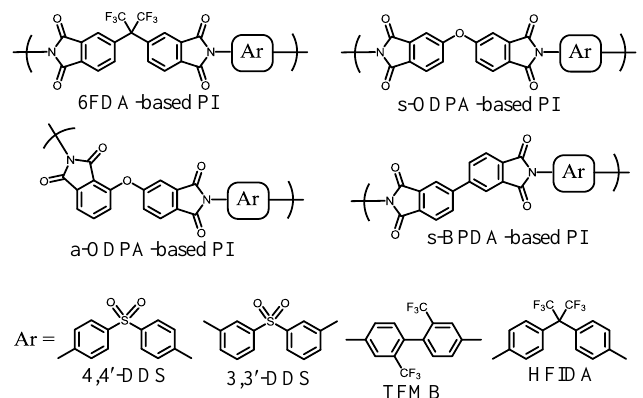
Figure 5. The structures of aromatic PI systems leading to non- or slightly colored films. 6FDA = 4,4 (cid:48) - (hexafluoroisopropylidene)diphthalic anhydride, s-ODPA = 4,4 (cid:48) -oxydiphthalic anhydride, a-ODPA = 3,4 (cid:48) -oxydiphthalic anhydride, s-BPDA = 3,3 (cid:48) ,4,4 (cid:48) -biphenyltetracarboxylic dianhydride, 4,4 (cid:48) -DDS = 4,4 (cid:48) -diaminodiphenylsulfone, 3,3 (cid:48) -DDS = 3,3 (cid:48) -diaminodiphenylsulfone, TFMB = 2,2 (cid:48) -bis (trifluoromethyl)benzidine, HFIDA = 4,4 (cid:48)